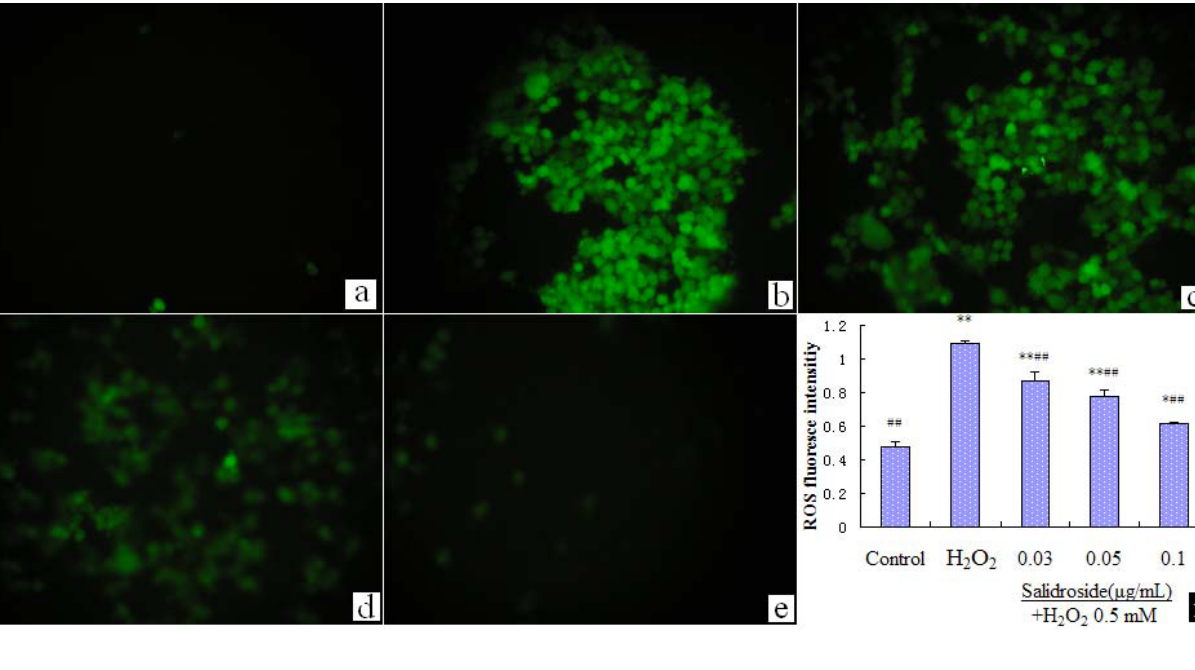
Figure 5. Salidroside inhibited H fluorescence microscope, Motic AE31 200×). ( a ). Control; ( b ). H salidroside + H O ; ( d ). 0.05 μ g/mL salidroside + H 2 2 ( f ). Statistical analysis of fluorescence intensity data with Motic Advanced Images 3.2 software. Cells were treated with salidroside followed by H